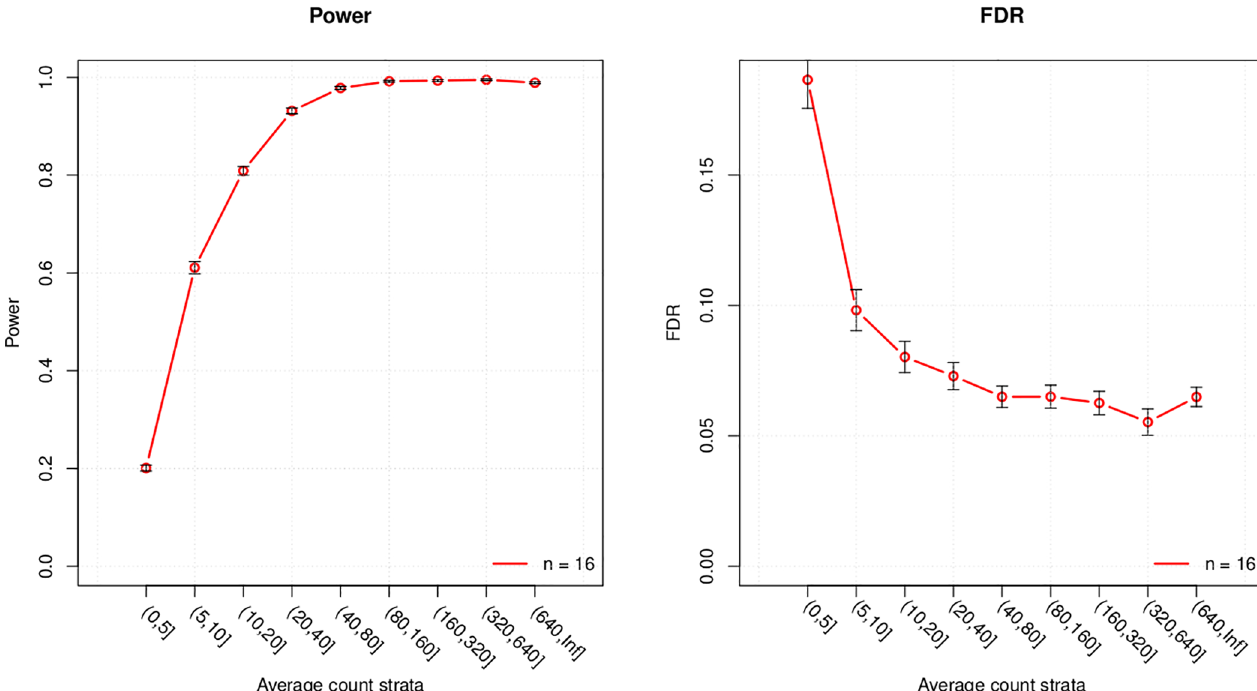
Fig 3. Dendogram view of the 14 network modules identified; 2 modules associatedwith SES are highlighted.